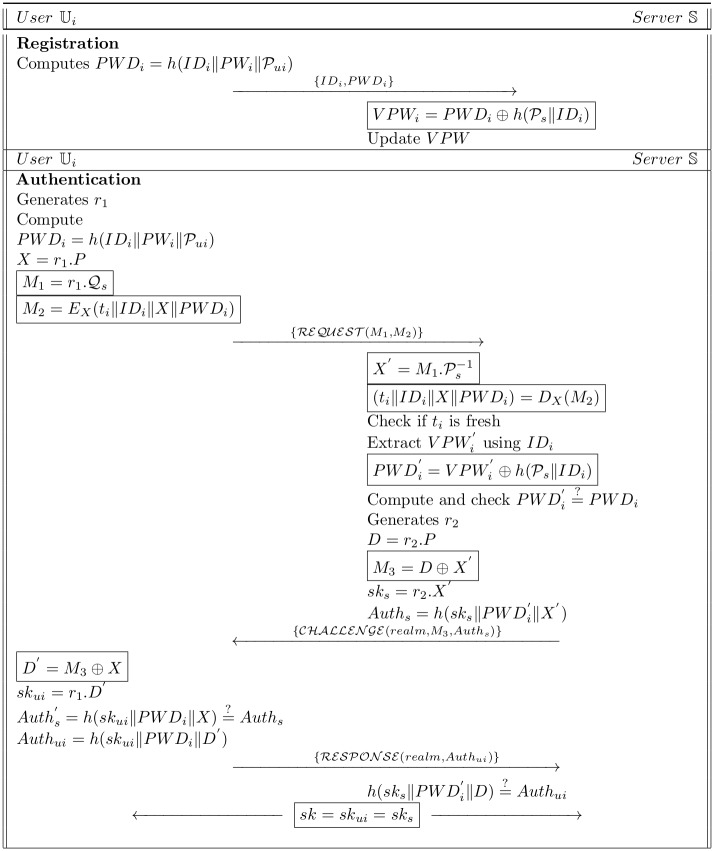
Proposed scheme.